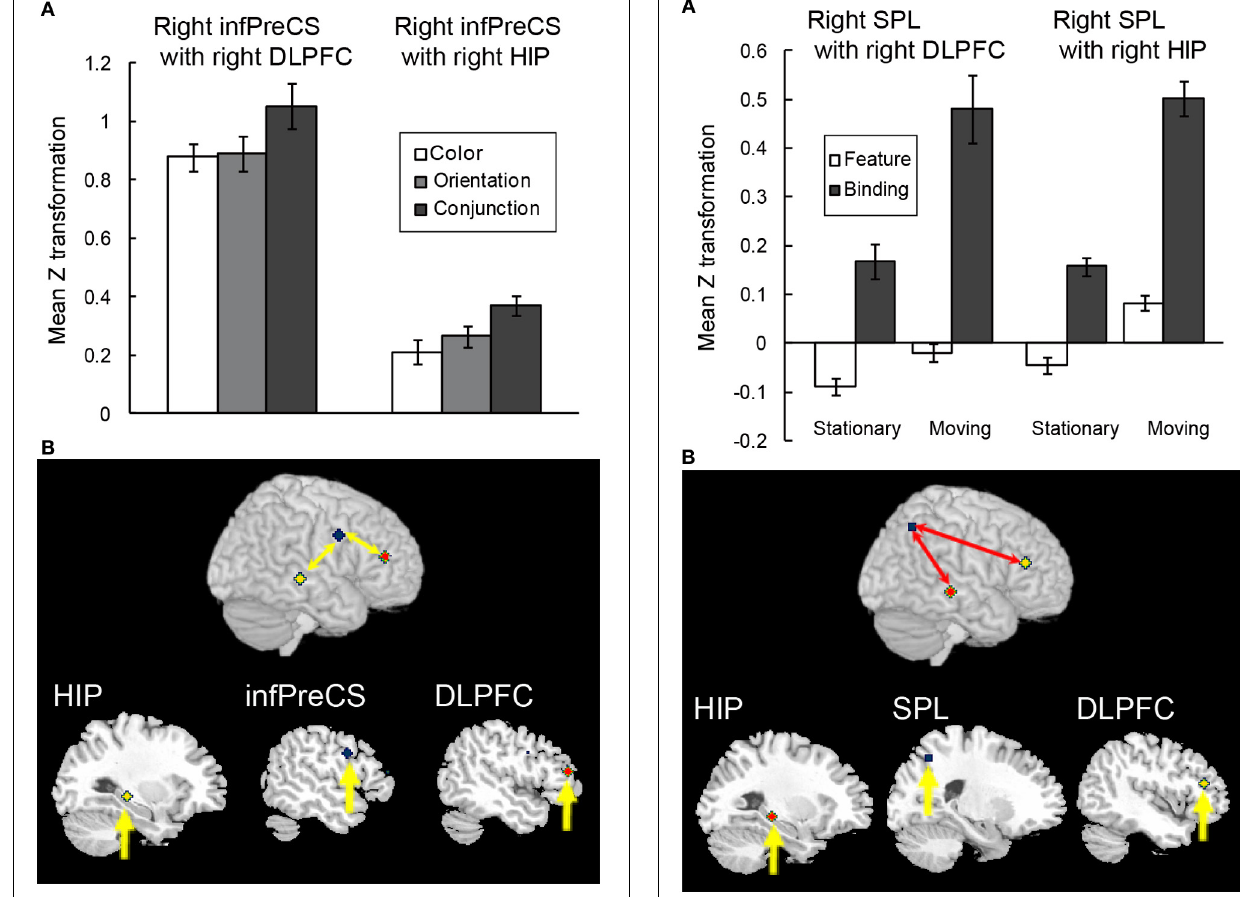
FIGURE 7 | Functional connectivity during the spatial updating of simple feature-location binding. (A) Functional connectivity between regions is plotted as the mean z score transformation of the beta-series correlations during maintenance of simple feature-location binding in the stationary and moving tasks. Error bars represent s.e.m. (B) A schematic of the spatial updating of simple feature-location binding network; network regions include the right hippocampus (MNI coordinates: 28, − 30, − 6; red cluster), the right SPL (MNI coordinates: 26, − 62, 48; blue cluster) and the right DLPFC (MNI coordinates: 44, 32, 18; yellow